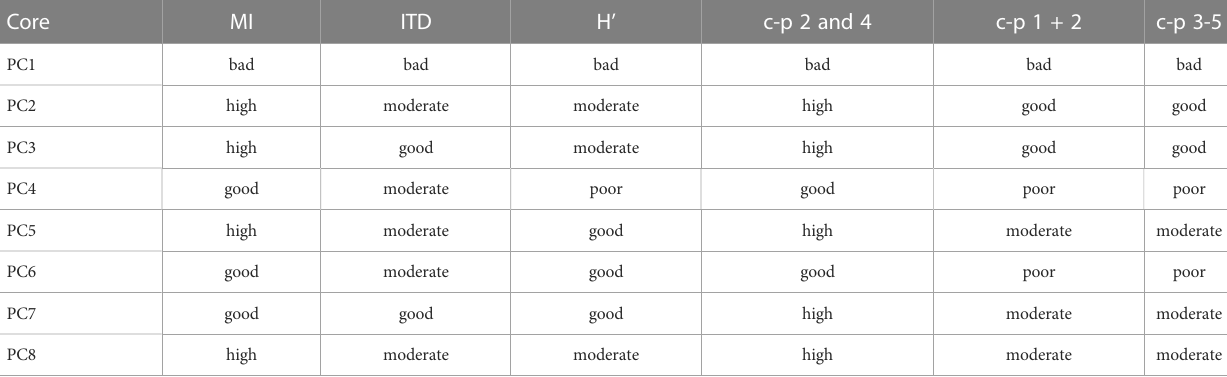
TABLE 4 Results of the environmental quality assessment within the uppermost centimeter of ferrous (PC1-4) and non-ferrous sediments (PC5-8) according to different nematode community descriptors as quality indicators.